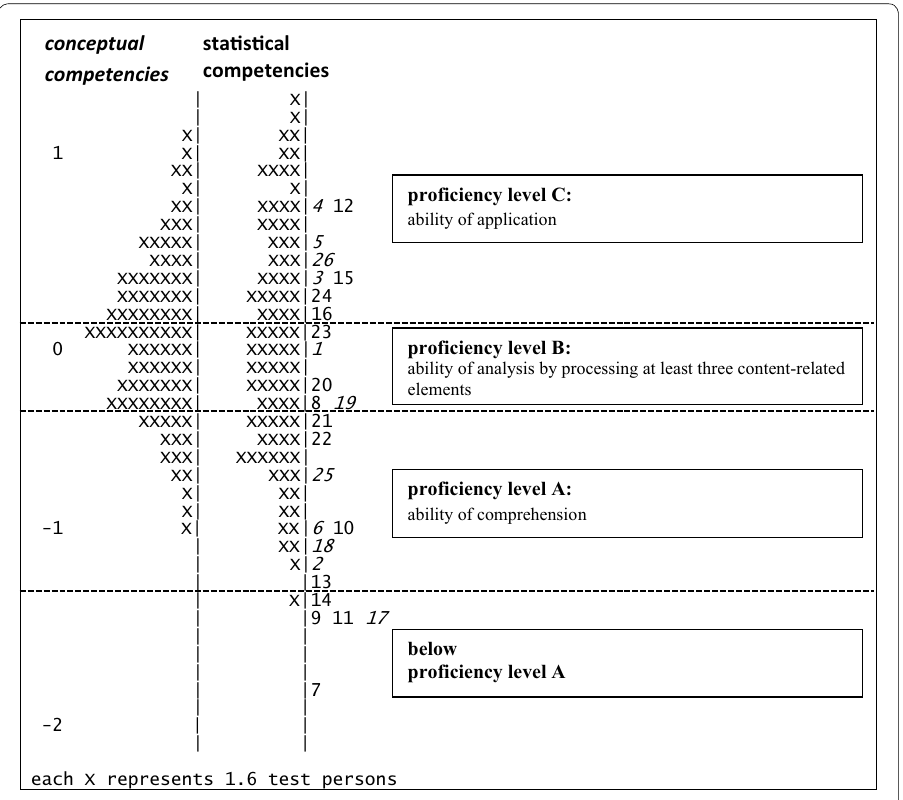
Fig. 3 Level model for CCER (based on the Wright map using the two‑dimensional PCM); distribution of the person and item